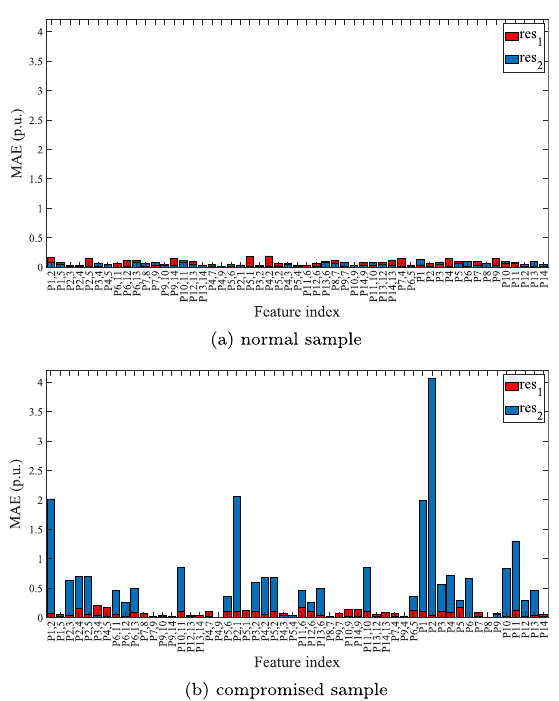
Fig. 4 Comparison under a normal sample and b compromised